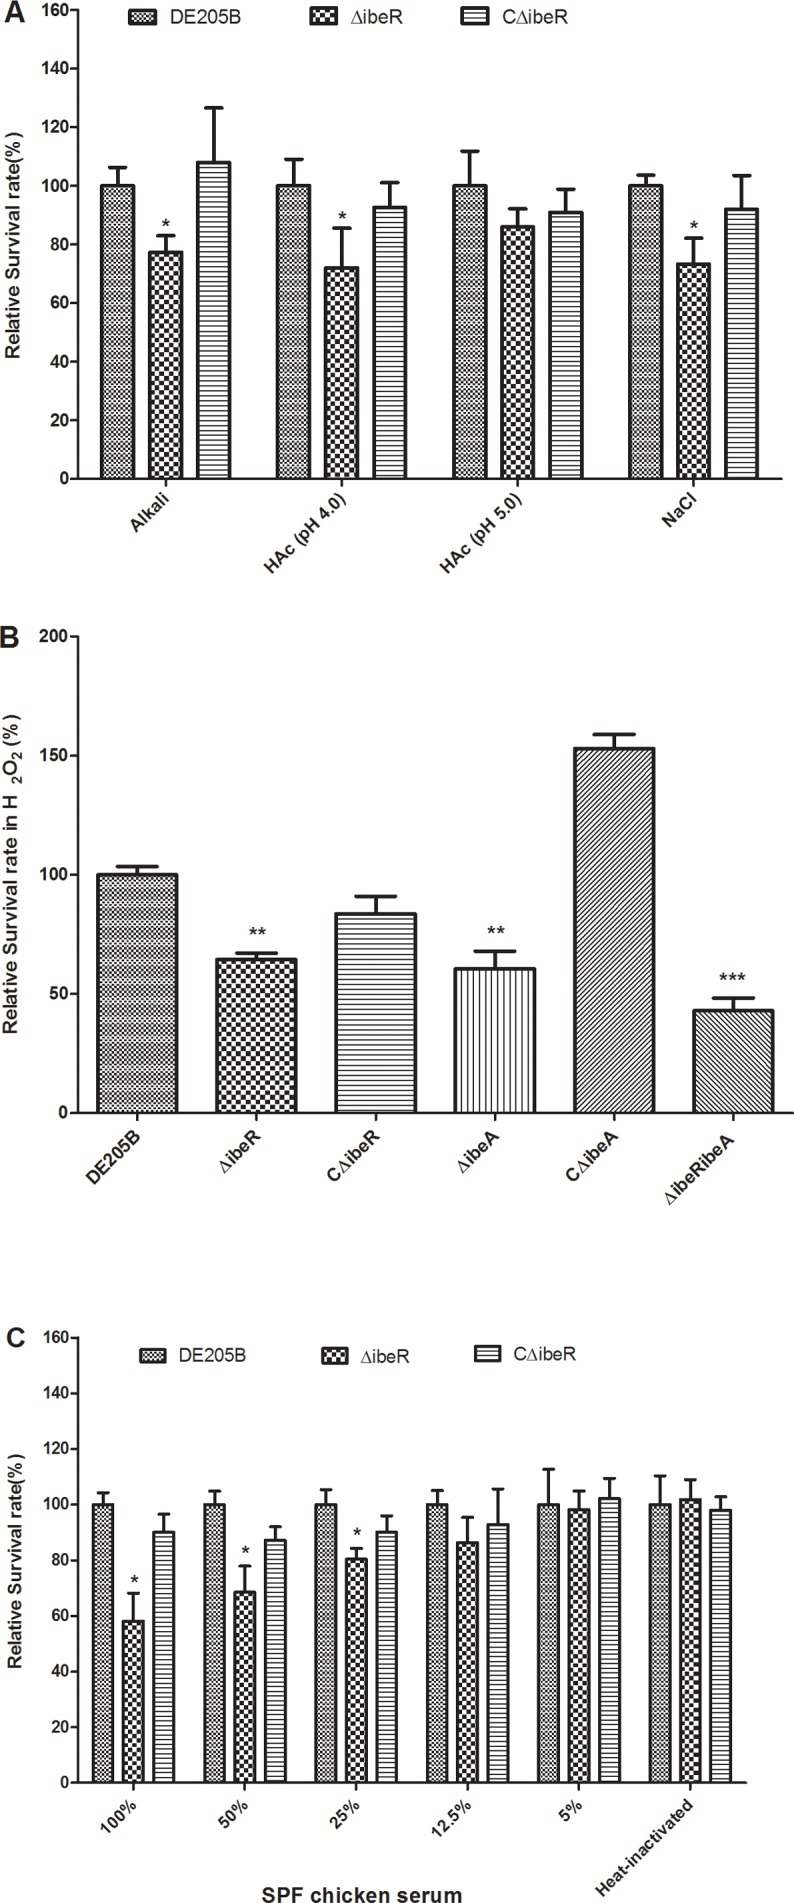
Bacterial resistance to environmental stress and SPF chicken serum.
(A) Resistance to environmental stress. Each strain was tested for different environmental stress including alkali endurance (pH 10 for 30 min), acid endurance (acetic acid, pH 4.0 and pH 5.0 for 20 min) and high osmolarity challenge (2.4 M NaCl for 1 h). Results were expressed as survival relative to wild-type strain DE205B. Survival of ΔibeR was significantly lower than DE205B (* p < 0.05). The complementation strain CΔibeR recovered the most resistance. (B) Sensitivity to oxidants of DE205B and its ΔibeR and ΔibeA derivatives. Bacterial suspensions were treated with 10 mM H2O2 at 37°C for 30 min. After stress exposure, bacteria were diluted in PBS and plated on LB agar. The data were expressed as survival relative to wild-type strain DE205B. Mutant strains ΔibeR, ΔibeA, ΔibeRibeA were more sensitive to H2O2 killing than the wild type strain DE205B (** p < 0.01; *** p < 0.001). Moreover, the resistance to H2O2 was restored for the complementation strains. (C) Resistance to SPF chicken serum. Bacteria were incubated at 37°C with SPF chicken serum at different dilutions, and counted at 30 min. Mutant strain ΔibeR showed significantly reduced resistance to SPF chicken serum compared to DE205B (* p < 0.05). The error bars indicate standard deviations.